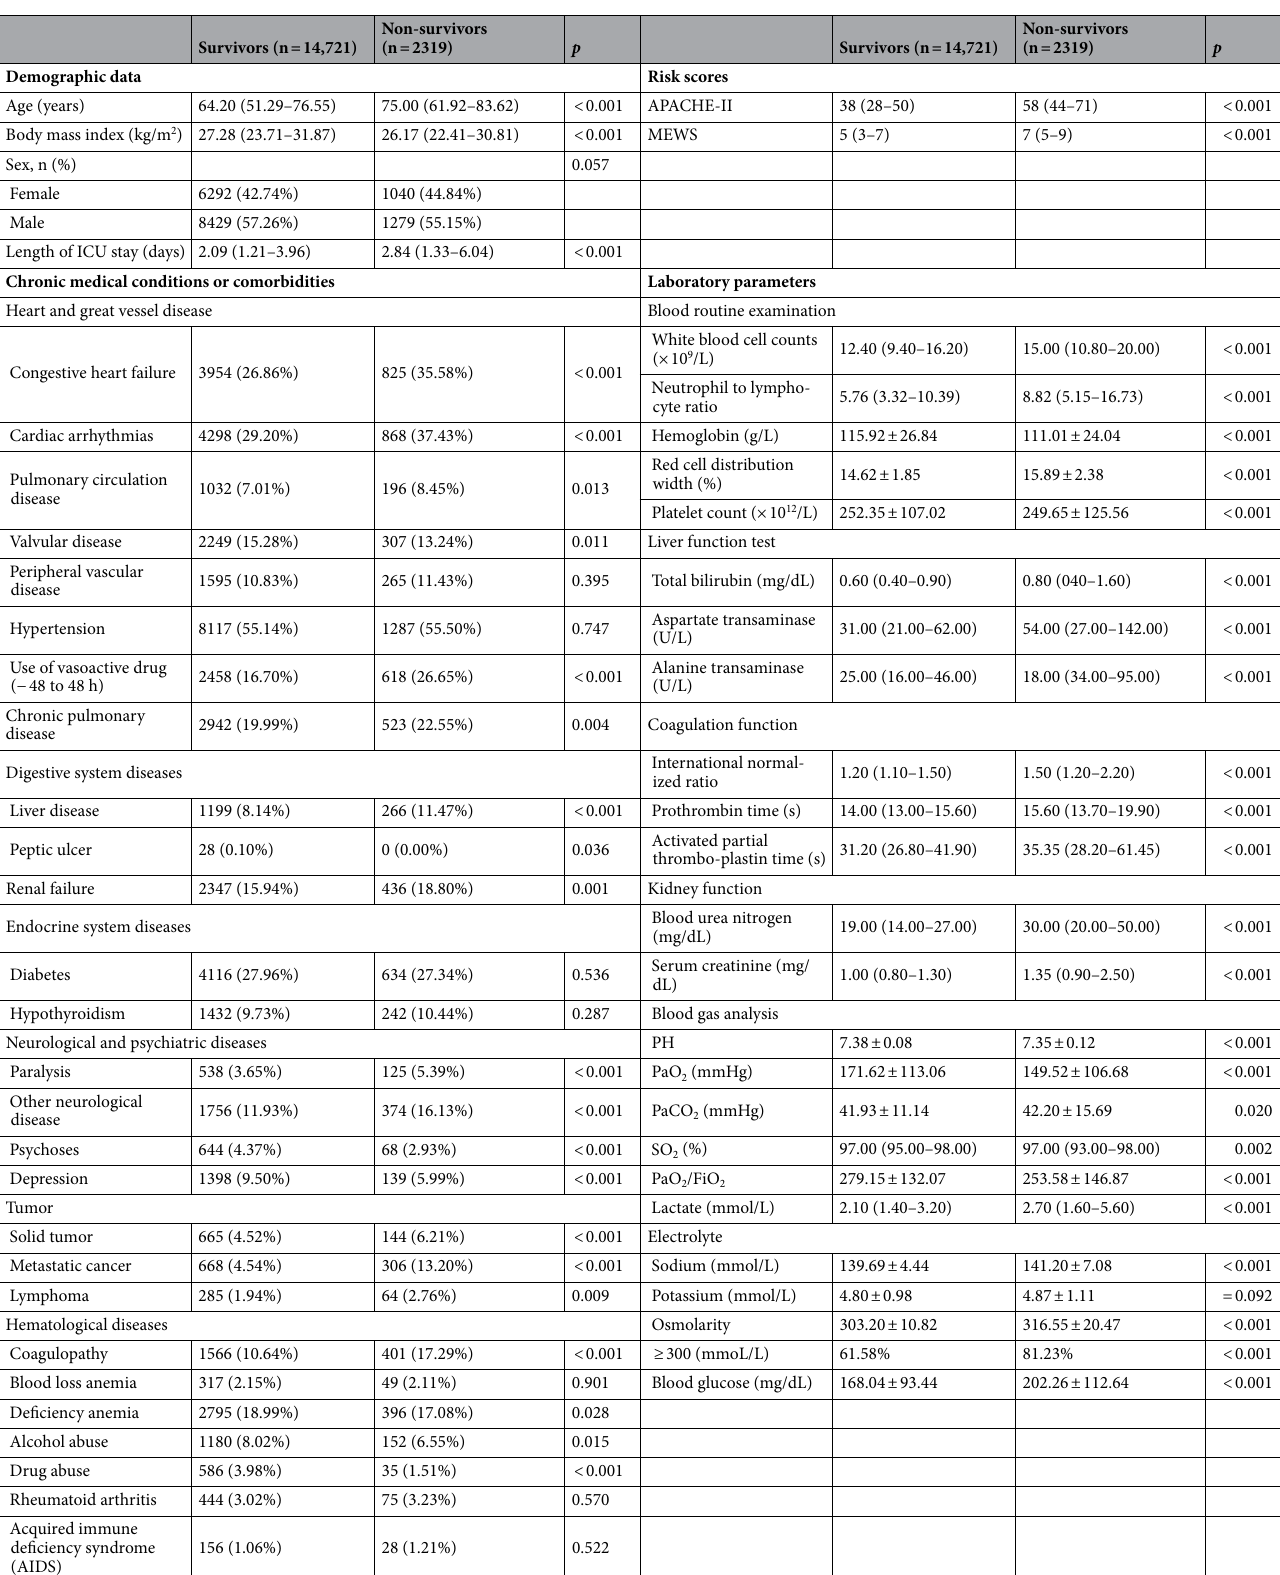
Table 5. Baseline characteristics and comparisons of demographics data, chronic medical conditions or comorbidities, risk scores and laboratory parameters of the study population between different survival status in validation